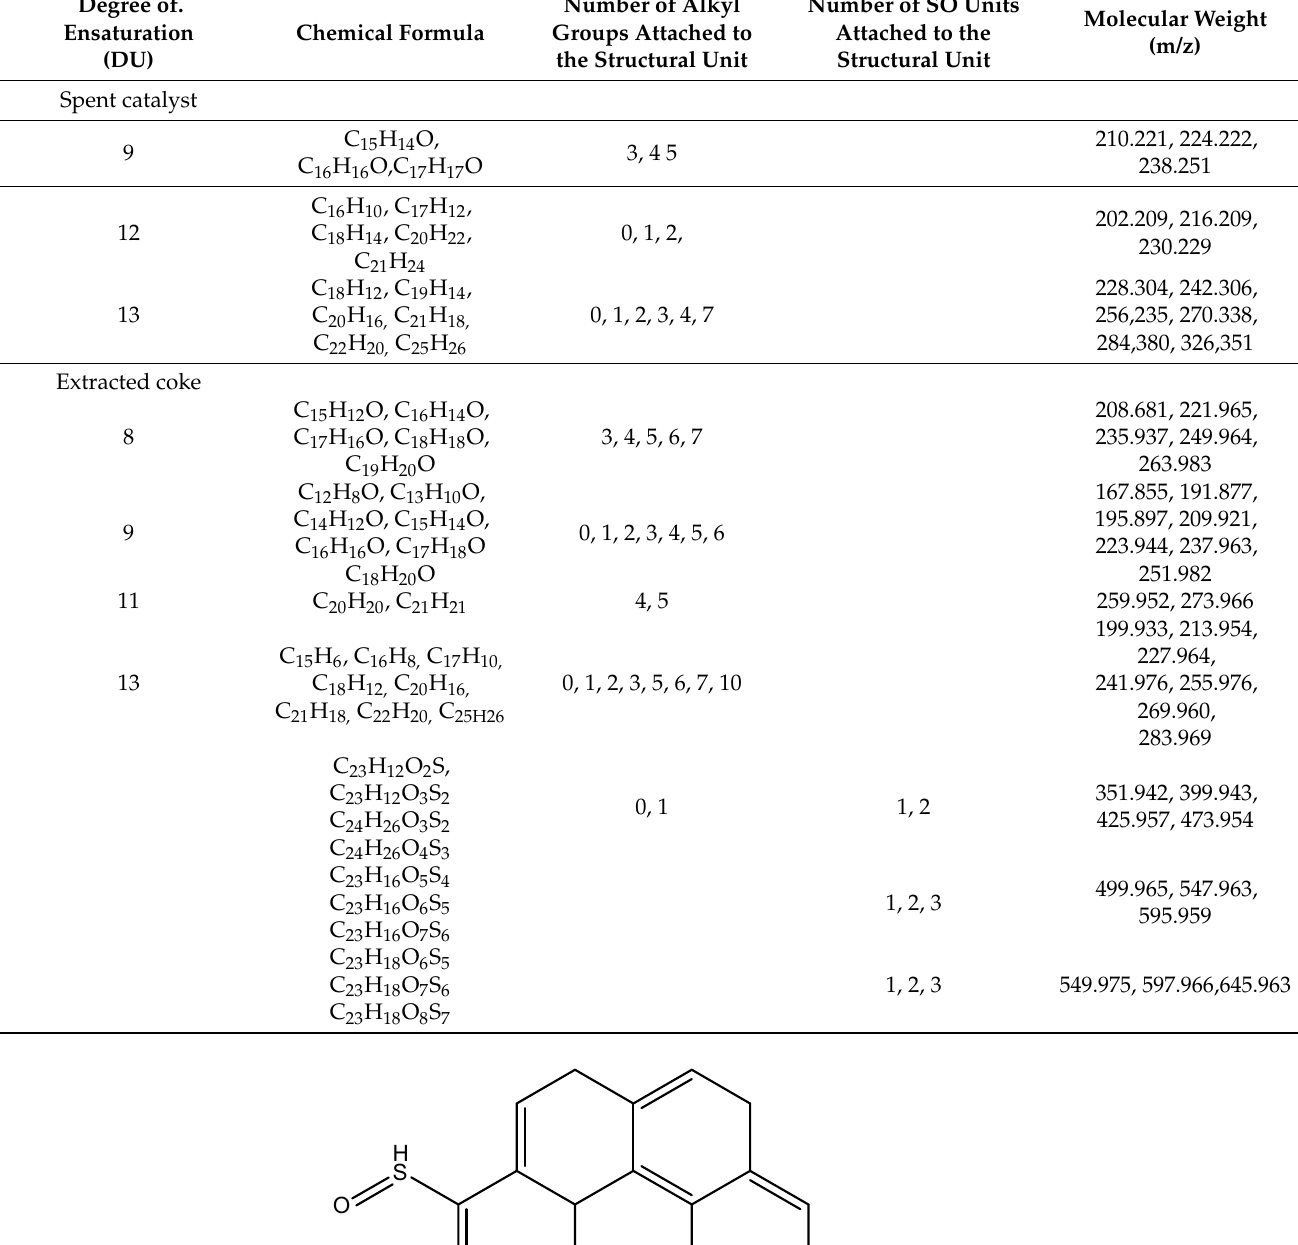
Table 3. LDI-TOF/MS identification results concerning the chemical composition of the spent catalyst. Degree of.